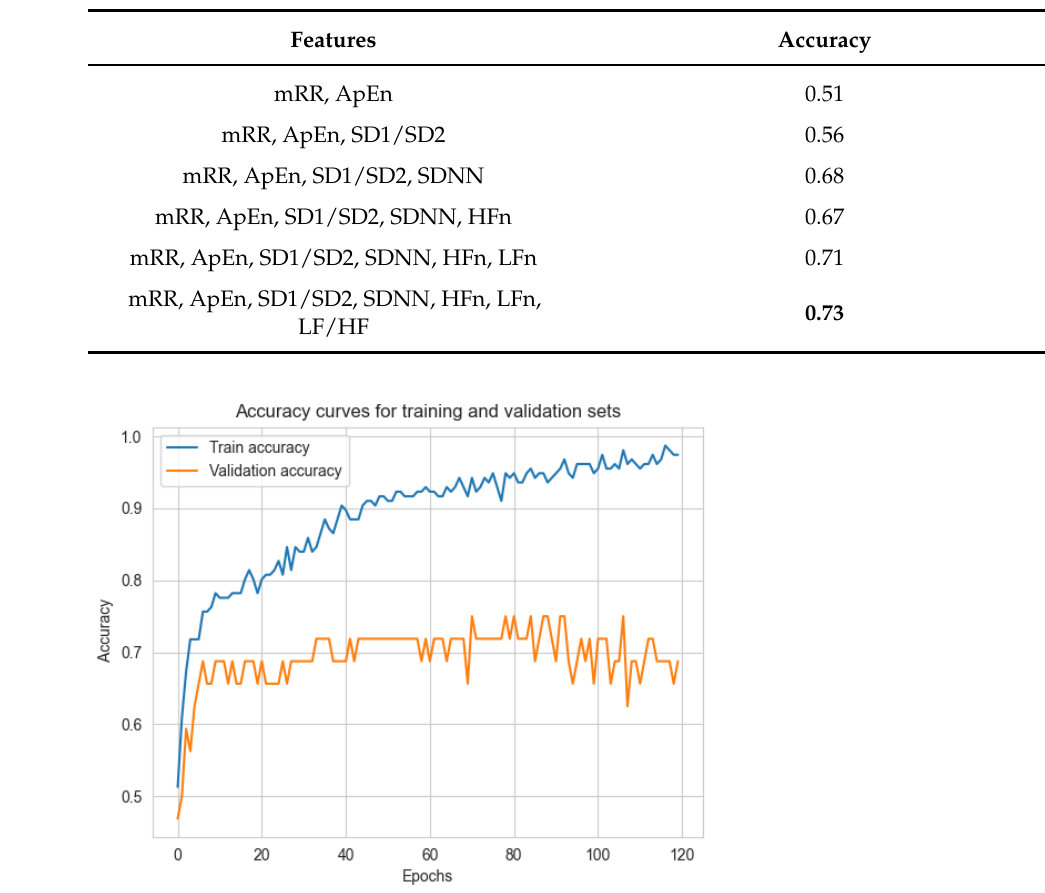
Table 2. Classification accuracy of the proposed method in stress state with different HRV features. In this sub-experiment, 28 subjects are randomly selected from the training set described in Section 5.1 to train the model, and 15 subjects are randomly selected from the remaining data for validation. The accuracy in the table is the average accuracy of three independent repeated experiments on the validation set. The number in bold represents the best result.